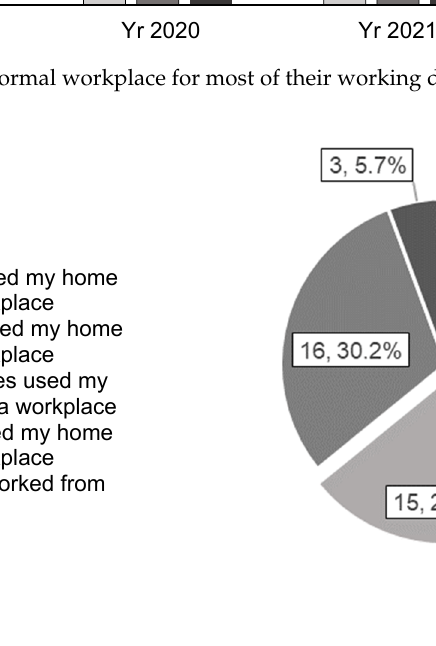
Figure 3. WFH experience before the COVID-19 pandemic for ( a ) all respondents and ( b ) respondents employed by an organization.